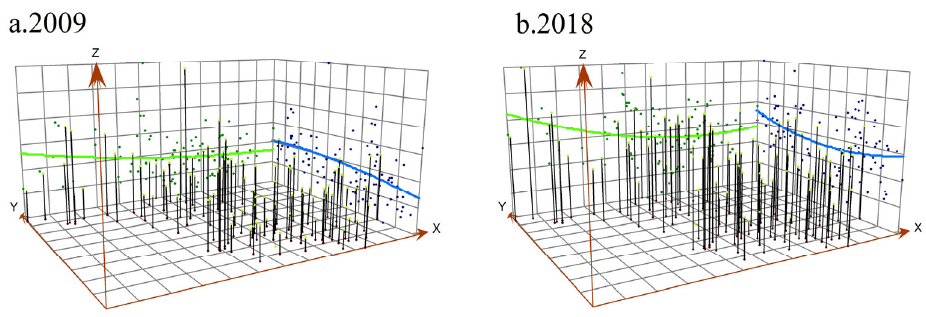
Figure 2. Trend analysis of urban vertical expansion in Jiangsu Province: ( a ) 2009, ( b ) 2018.